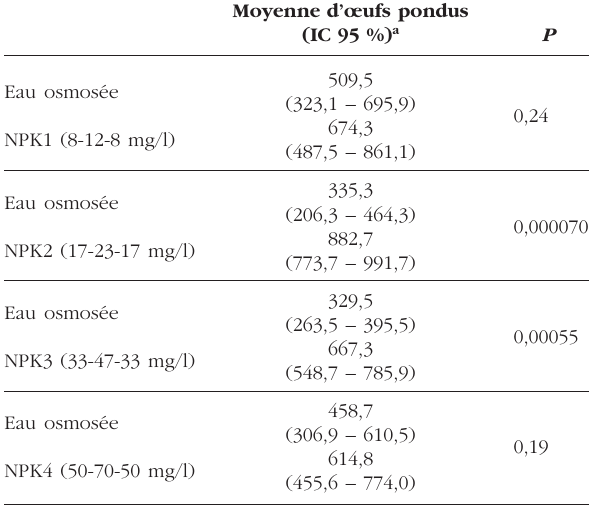
Tableau II. – Moyenne d’œufs pondus (six répliques) dans des gîtes de ponte contenant de l’eau osmosée versus NPK1, NPK2, NPK3 ou